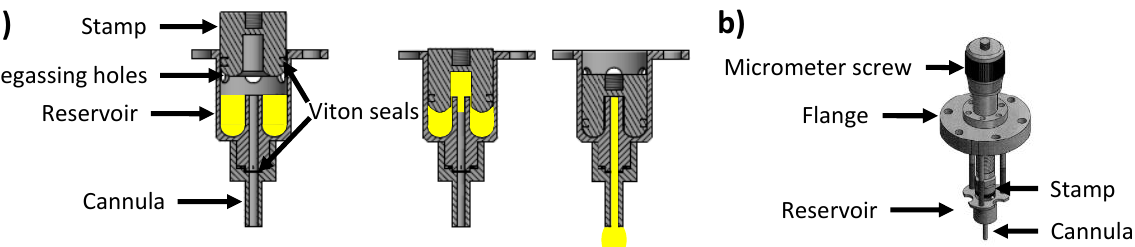
Figure 2. Concept and construction to form a drop in HV: ( a ) Representation of the inner part in the vacuum consisting of a stamp, reservoir with degassing holes and cannula. The stamp is pushed in the reservoir to press the liquid (in yellow) into the cannula forming a drop at its tip. ( b ) Full setup with the micrometre screw moving the stamp in a vertical direction.